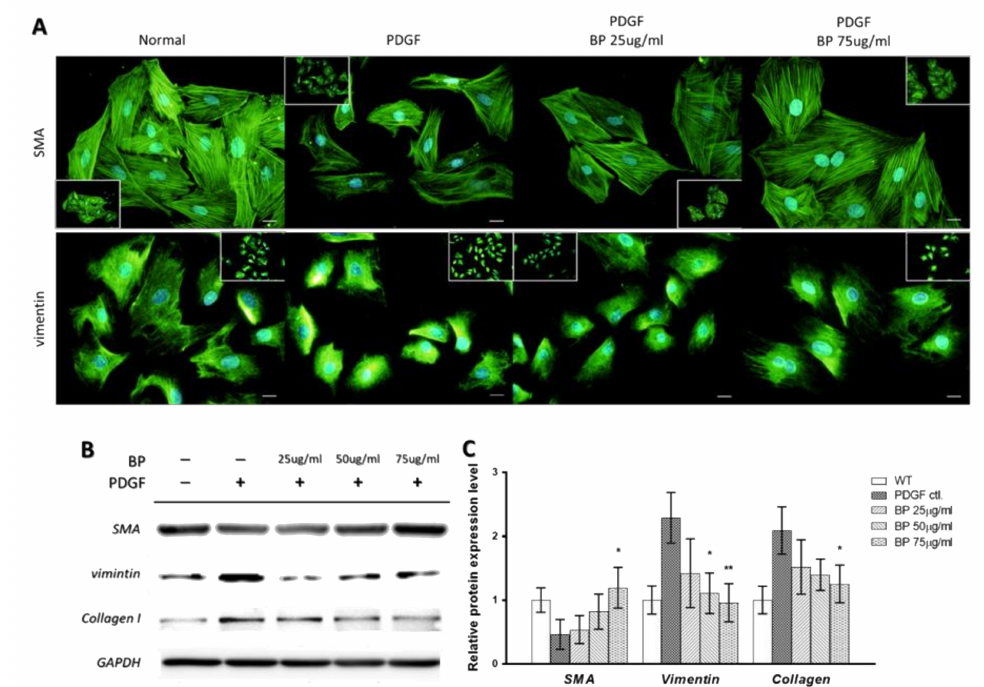
Figure 1. n-Butylidenephthalide (BP) inhibited PDGF-induced phenotypic switch. Measurements of morphologyandproteinexpressioninA7r5treatedwithBP:( A )RepresentativeimagesofPDGF-induced A7r5 in the absence or presence of BP (25 and 75 µ g / mL) for 24 h. Scale bar = 50 µ m; ( B , C ) Western blotting analysis of phenotypic marker expression. All data are presented as the means ± standard deviation of three independent experiments. * p < 0.05 and ** p < 0.01 versus the PDGF